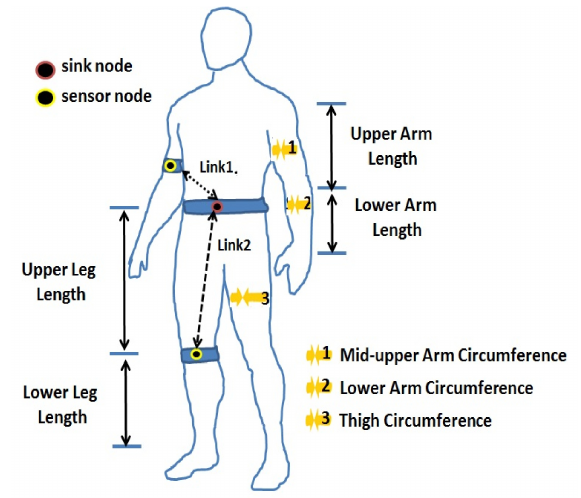
Figure 1. Node location and anthropometric